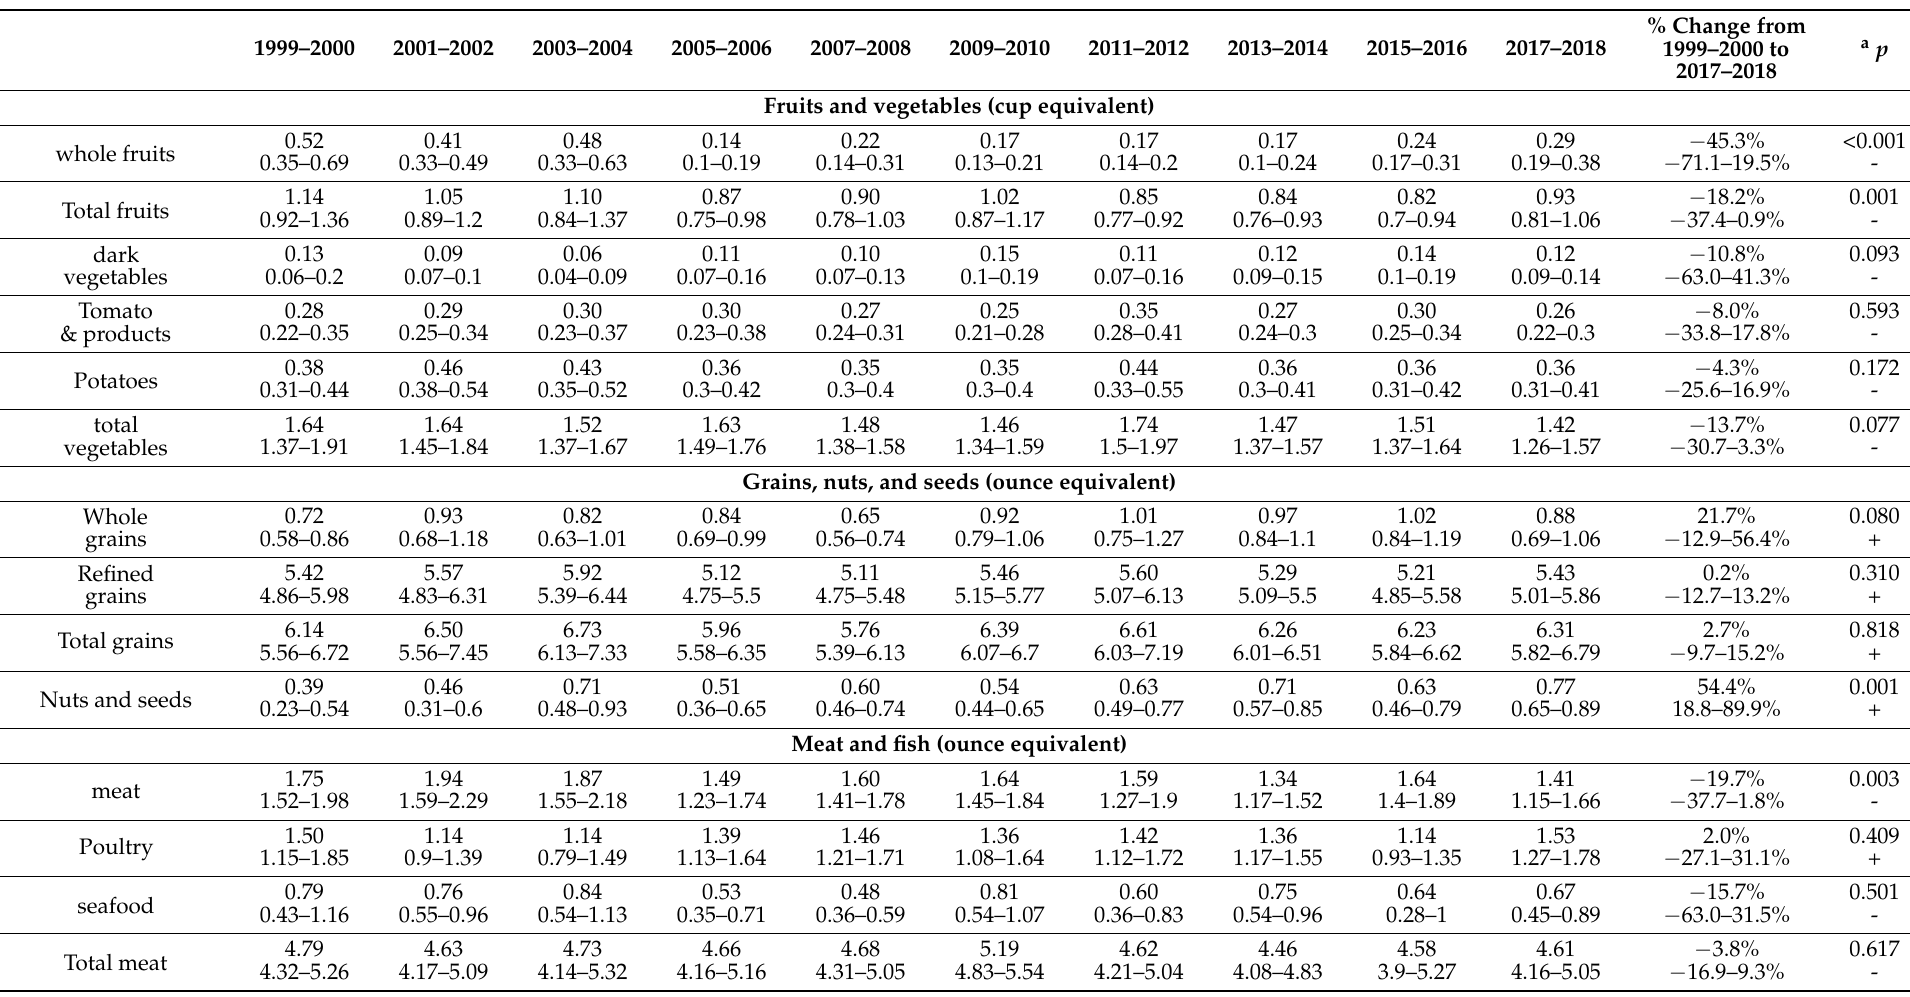
Table 3. Estimated means, their 95% CI, and trends of major food components (categories) of US type 2 diabetic adults of NHANES survey cycles between